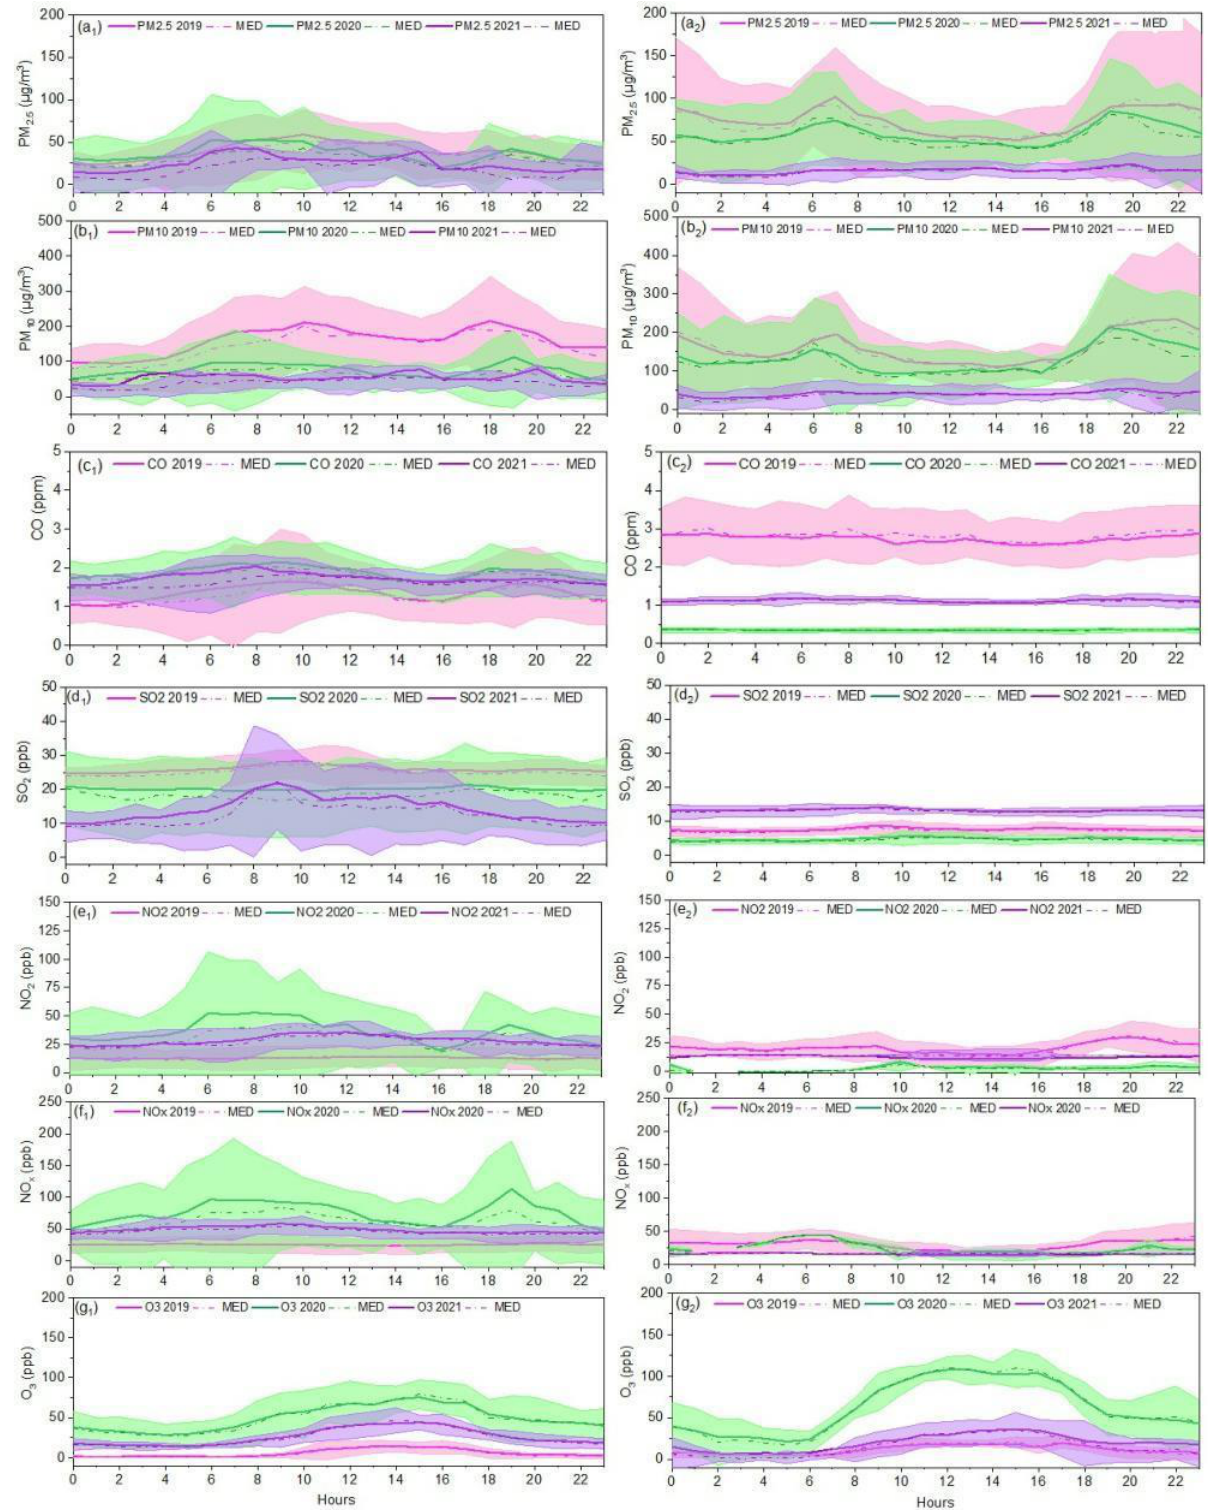
Figure 5. Average diurnal variation of PM 2.5 , PM 10 , CO, SO 2 , NO 2 , NO x , and O 3 during LD2020, LD2021, and the coinciding base year 2019. Continuous and dotted lines represent mean and median, respectively, and the shaded region shows the IQR at site #1 ( a 1 – g 1 ) and site #2 ( a 2 – g 2 ).